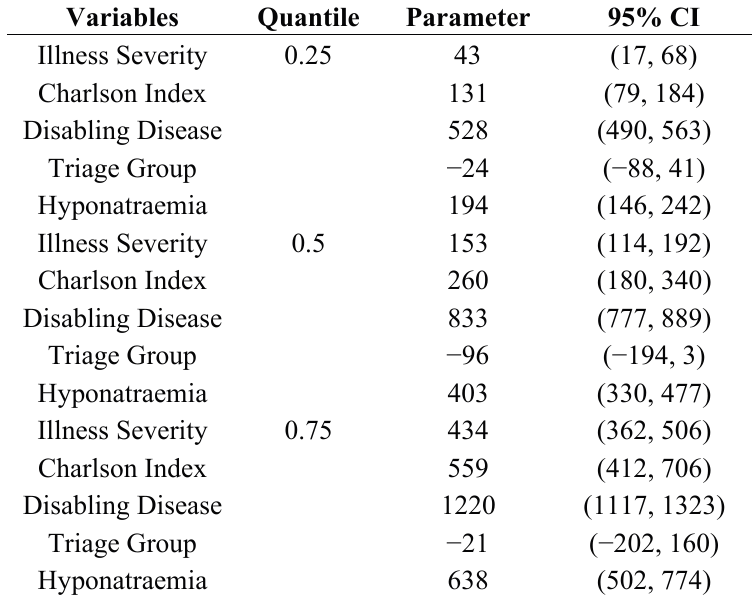
Table 3. Quantile regression parameters of Episode Cost by Predictor